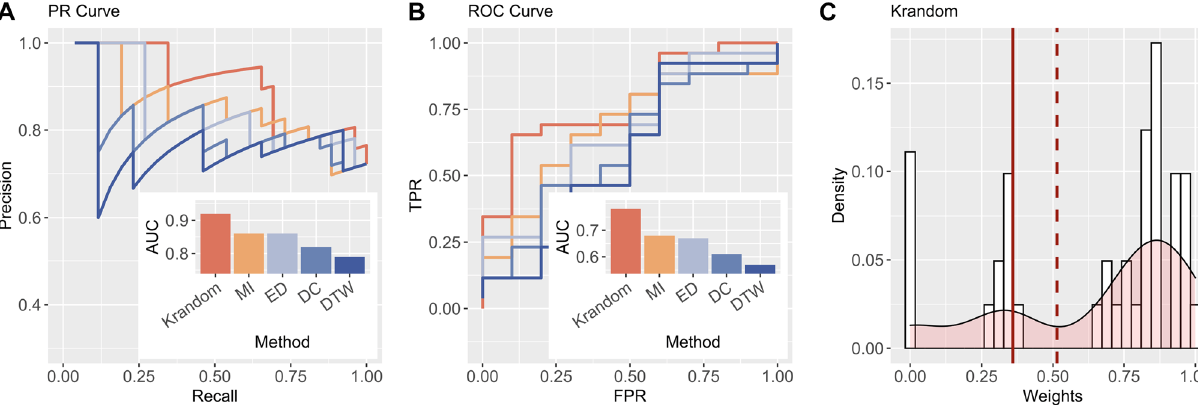
Fig. 8 Topology inference of pigeon flocking. A PR AUC of different methods, B ROC AUC of different methods, C GMM-based threshold of K-similarity